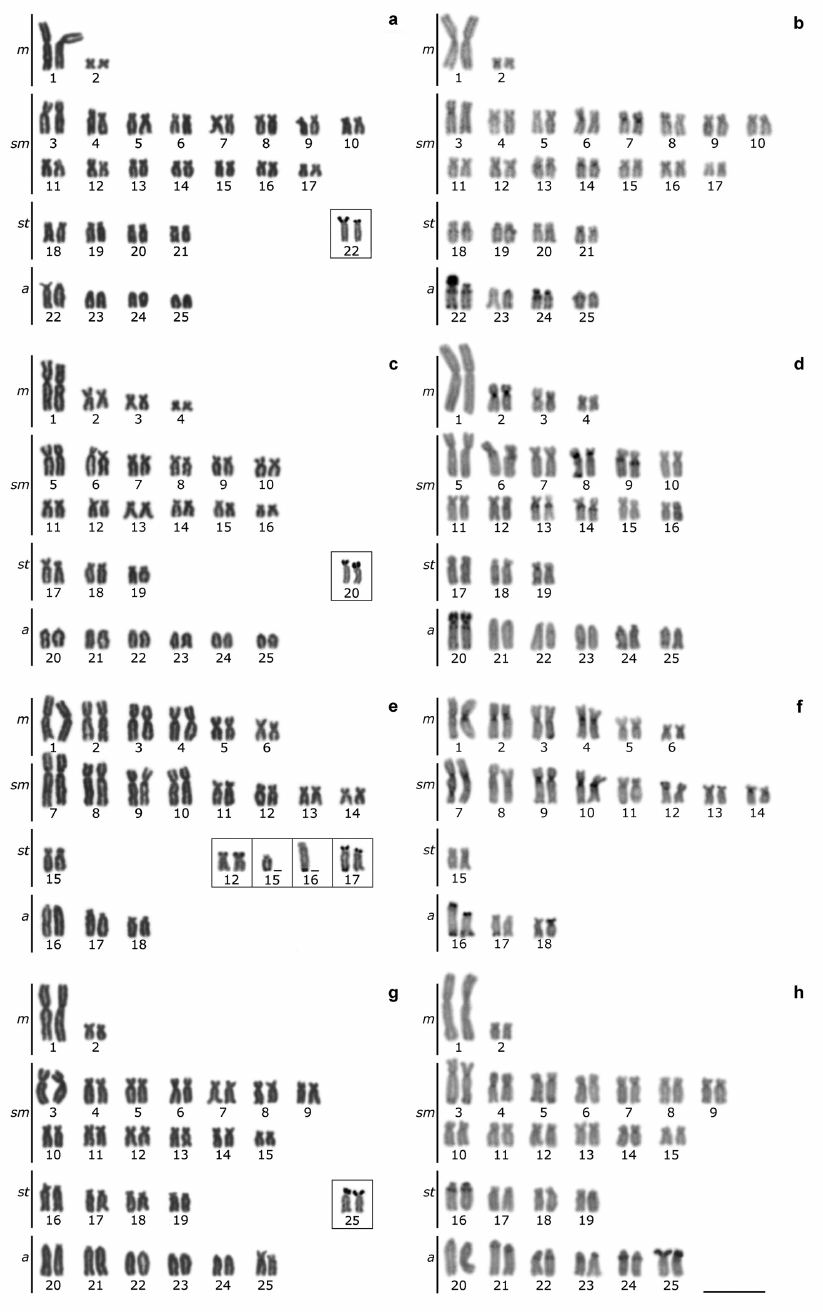
Figure 1. Karyotypes arranged from Giemsa-stained chromosomes of: a A. abramis c A. asuncionensis e A. correntinus g A. sp.; and from C-banded chromosomes of: b A. abramis d A. asuncionensis f A. cor- rentinus h Astyanax sp. The AgNORs bearing chromosomes are framed. Bar = 10